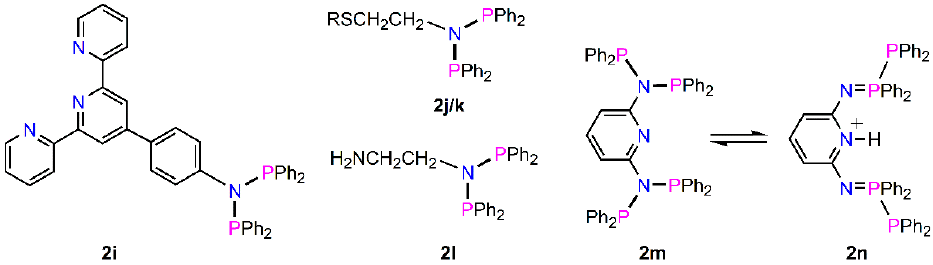
Figure 4. Selected examples of functionalised bis(phosphino)amines.